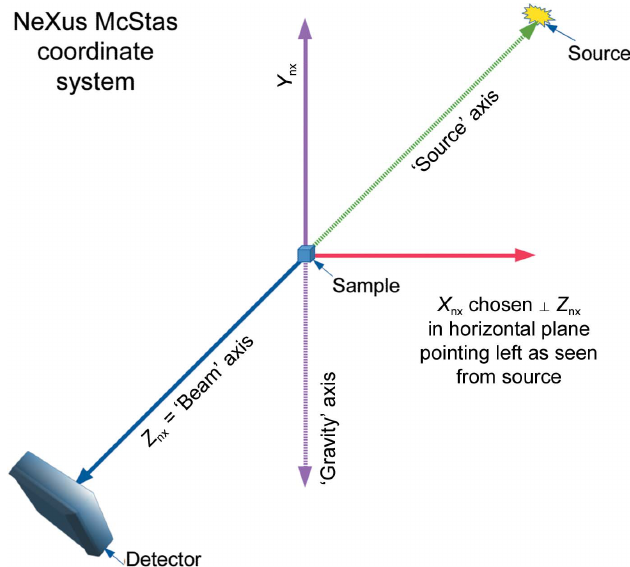
Figure 2 The NeXus/HDF5 files specify axes in the NeXus McStas coordinate system. The standard coordinate frame in NeXus is the McStas coordinate frame, in which the Z axis points in the direction of the incident beam, the X axis is orthogonal to the Z axis in the horizontal plane and pointing left as seen from the source, and the Y axis points upwards to form a right-handed axis system. The origin is in the sample.